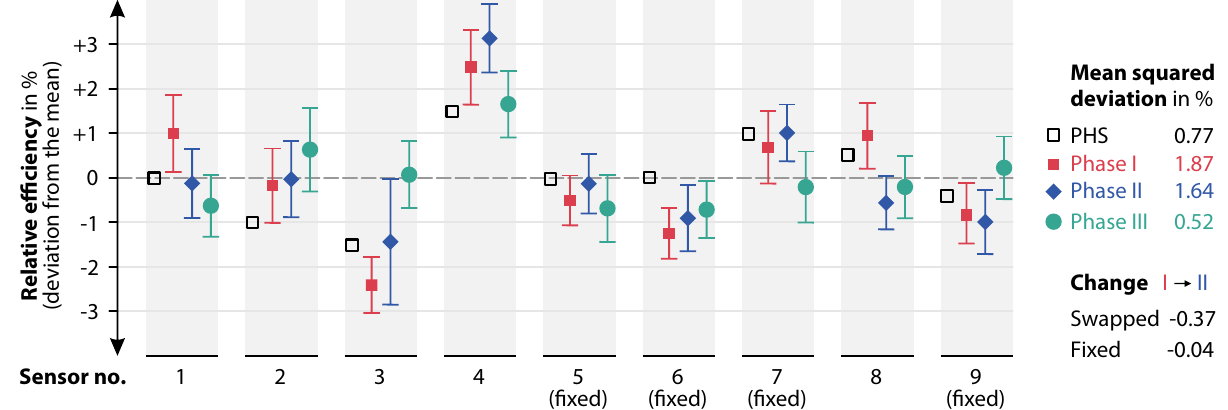
Figure 5. Relative deviation of the neutron count rates around their ensemble mean, calculated before (Phase I) and after (Phase II) the swap of sensor positions and after adjusting the detector parameters (Phase III). In addition, theoretical values before Phase III have been determined from the location of the discriminator in the pulse height spectrum (PHS, black). Error bars are based on the standard deviation of the count rate for each sensor.